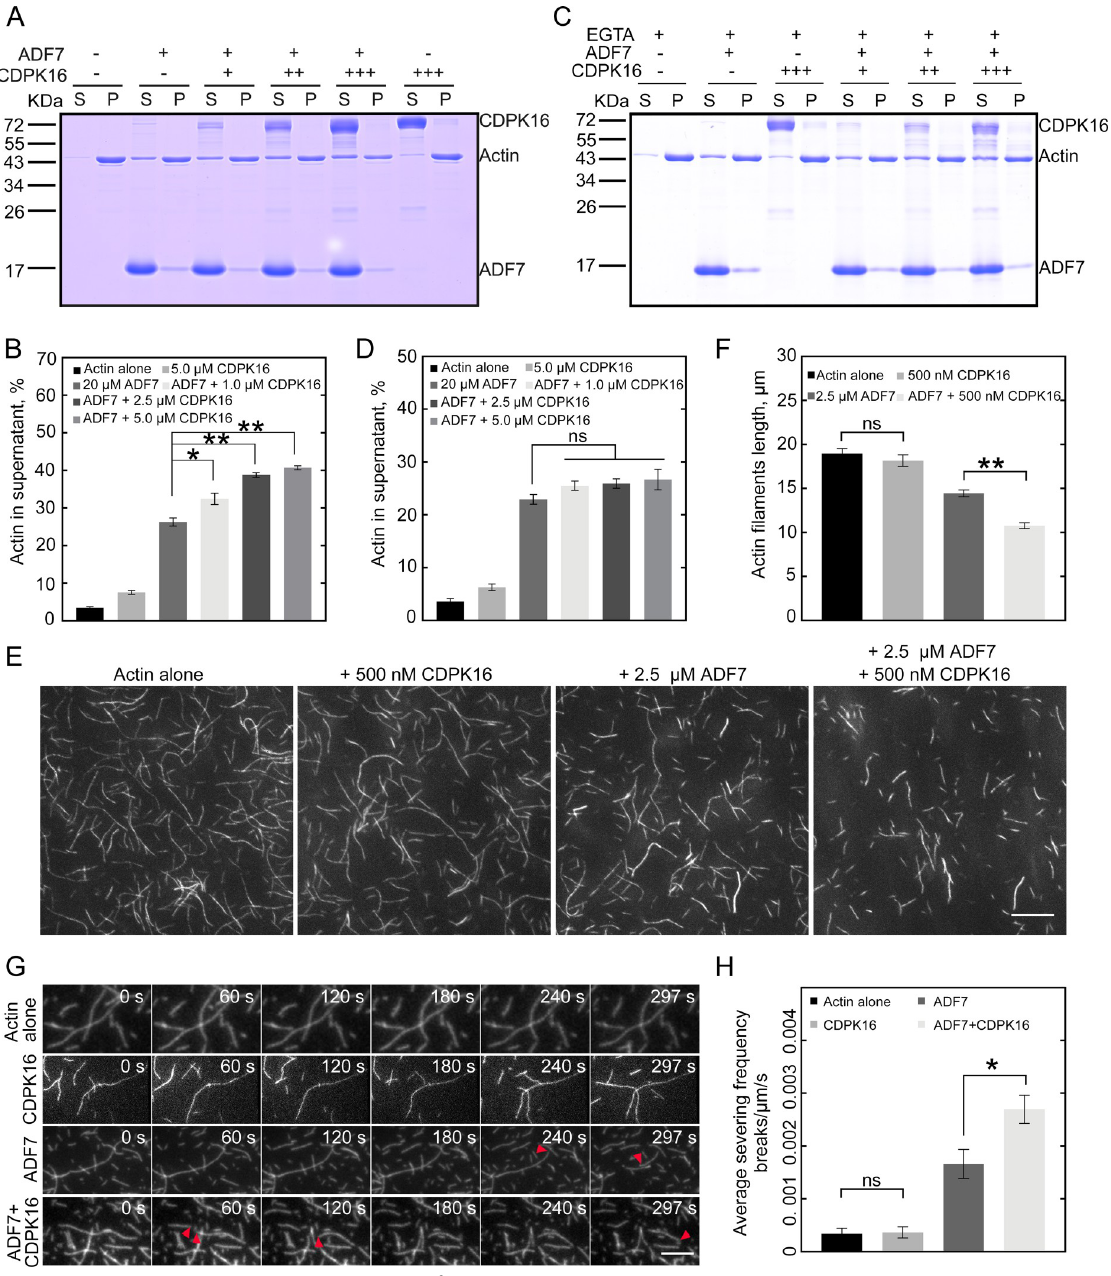
Fig 3. CDPK16 enhances the activity of ADF7 in a Ca 2+ -dependent manner in vitro . ( A ) SDS-PAGE analysis of the protein samples from a high-speed F-actin co-sedimentation experiment in the presence of Ca 2+ . F-actin, 3 μ M; ADF7, 20 μ M; CDPK16 (+), 1.0 μ M; CDPK16 (+ +), 2.5 μ M; CDPK16 (+++), 5.0 μ M. The supernatant fractions (S) and pellets (P) were separated on SDS-PAGE gels, and proteins were detected by Coomassie Brilliant blue R 250 staining. The original pictures are available in S1 Raw Images. ( B ) Quantification of the amount of actin in the supernatant fractions shown in ( A ). Data are presented as mean ± SE, n = 3, * P < 0.05 and ** P < 0.01 by Student’s t test. Numerical data underlying this panel are available in S3 Data. ( C ) SDS-PAGE analysis of the protein samples from a high-speed F-actin co- sedimentation experiment in the absence of Ca 2+ . The conditions were exactly the same as in ( A ) except for the presence of 0.5 mM EGTA instead of 0.5 mM CaCl 2 in the kinase reaction buffer. F-actin, 3 μ M; ADF7, 20 μ M; CDPK16 (+), 1.0 μ M; CDPK16 (++), 2.5 μ M; CDPK16 (+++), 5.0 μ M. The original pictures are available in S1 Raw Images. ( D ) Quantification of the amount of actin in the supernatant fractions shown in ( C ). Data are presented as mean ± SE, n = 3, ns, no significant difference by Student’s t test. Numerical data underlying this panel are available in S3 Data. ( E ) Images of actin filaments stained with equimolar Rhodamine-Phalloidin. The concentration of actin filaments is 2 μ M. Bar = 10 μ m. ( F ) Quantification of the length of actin filaments. Data are presented as mean ± SE, n = 3, ns, no significant difference, ** P < 0.01 by Student’s t test. Numerical data underlying this panel are available in S3 Data. ( G ) Time-lapse images of actin filaments. F-